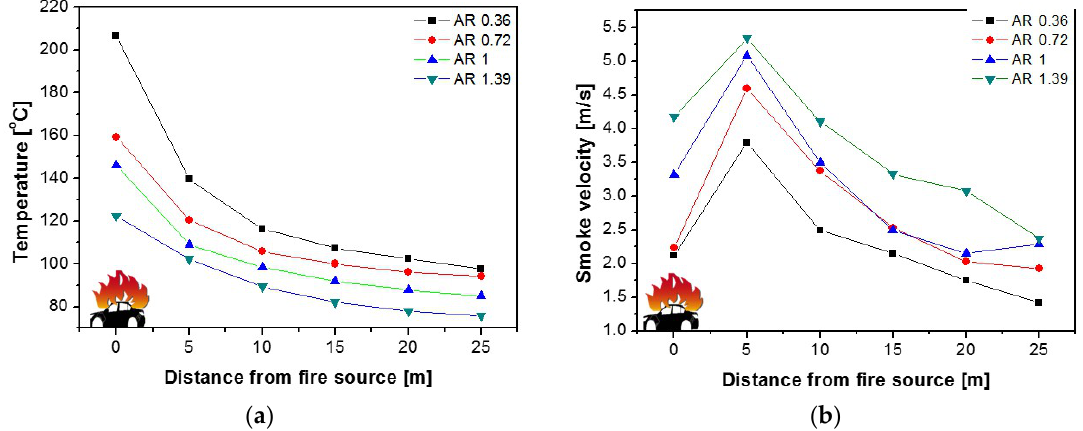
Figure 6. Temperatures and smoke velocities below 0.2 m of the tunnel ceiling for varying aspect ratio and distances from fire source at 1500 s. ( a ) Temperature distribution, ( b ) Smoke velocity distribution.